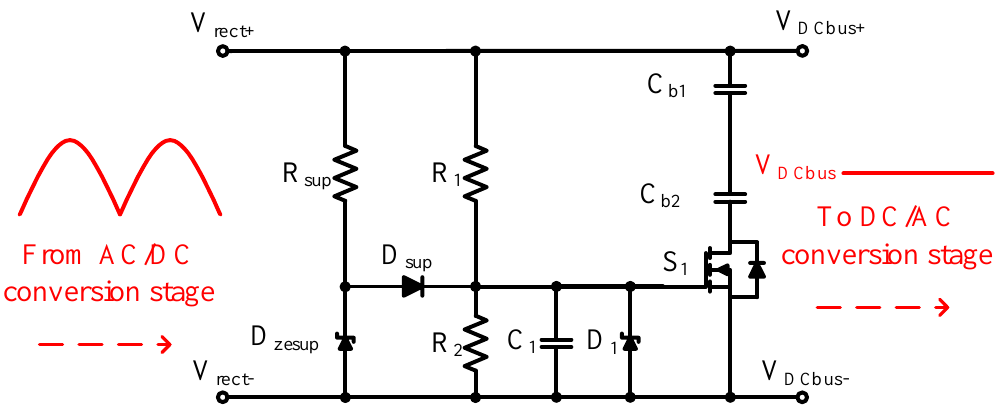
Figure 7. The pre-charge circuit used to soft charge the capacitors of the DC bus.